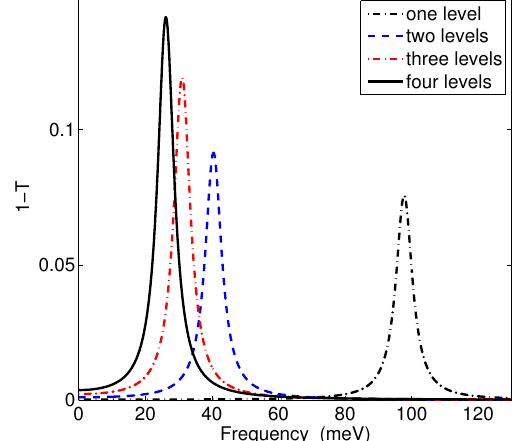
Figure 2. Light transmission through graphene with low carrier concentrations when carriers fill only one, two, three or four levels.